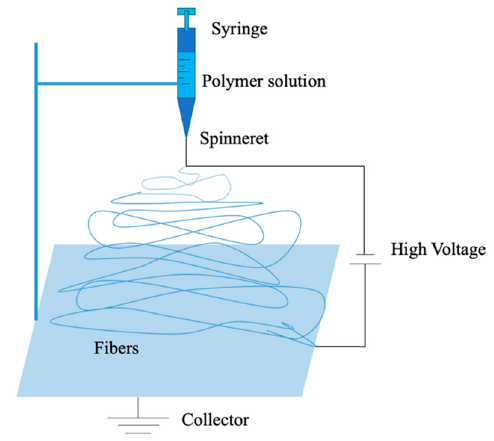
Figure 20. Set-up for electrospinning configuration.